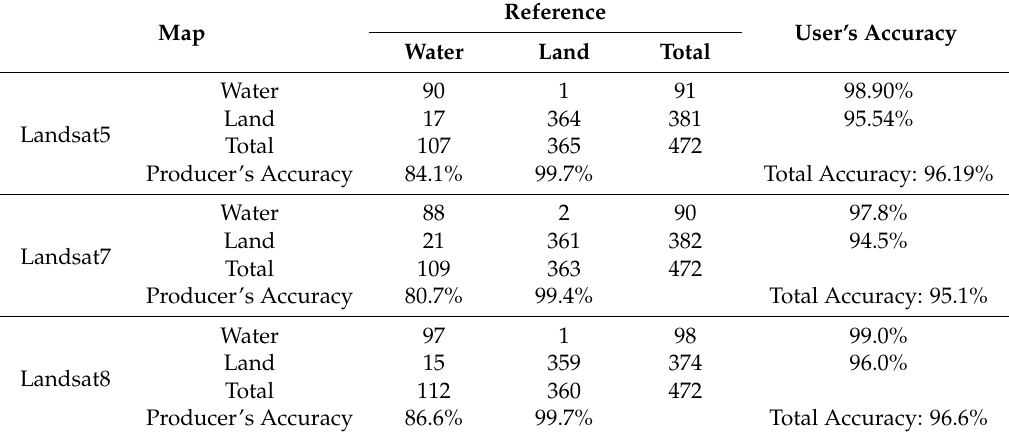
Table 1. The accuracy of